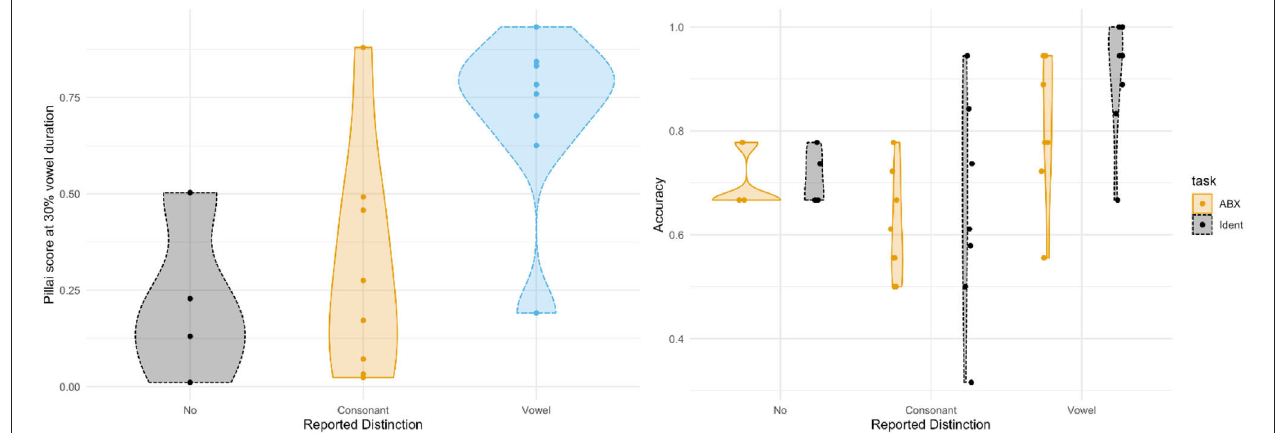
FIGURE 12 | Pillai scores at 30% vowel duration (left) and perception accuracy rates (right) by self-reported distinction for writer-rider. Pillai scores and individual mean accuracy for perception tasks at 30% for writer-rider, separated by reported distinction. No, no self-reported contrast; Consonant, reported contrast and described difference as consonantal; and Vowel, reported contrast and described difference in terms of vowel